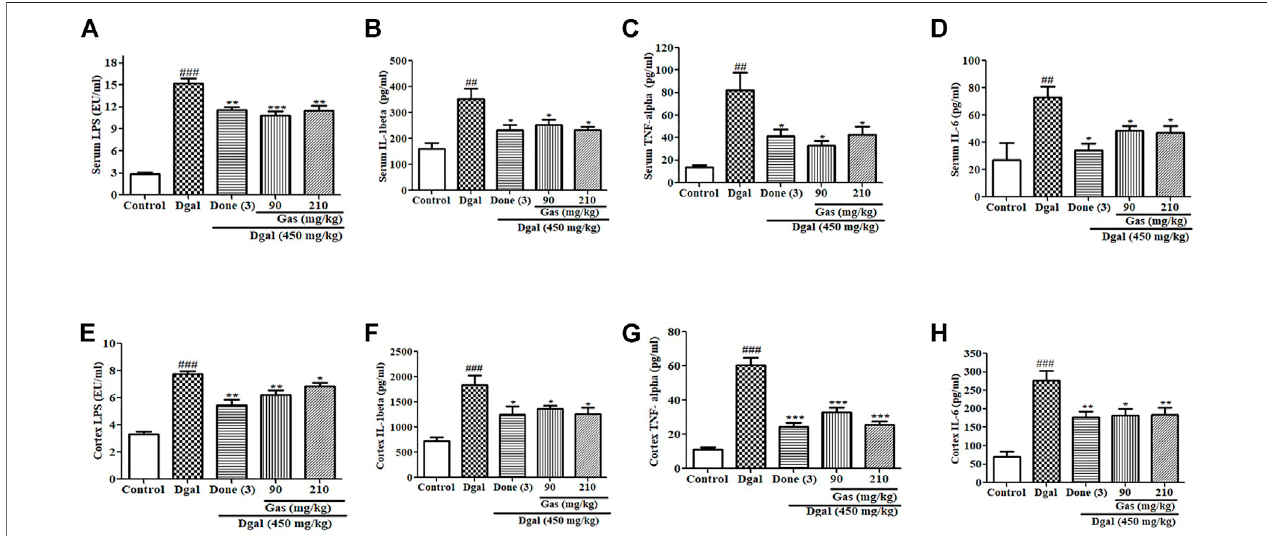
FIGURE4| EffectsofGasonproin fl ammatorycytokinesintheserumandcerebralcortex. (A – D) ChangesintheserumLPS,IL-1 β ,TNF- α ,andIL-6ofADmiceafter treatment with Gas, respectively. (E – H) Concentration of cerebral cortex LPS, IL-1 β , TNF- α , and IL6. Sample numbers are fi ve, and the data are presented as means ± SEM. #, ##, and ### indicate signi fi cant differences at p < 0.05, p < 0.01, and p < 0.001 compared with those in the normal control, respectively; *, **, and *** indicate signi fi cant difference at p < 0.05, p < 0.01, and p < 0.001 compared with those of the Dgal group,